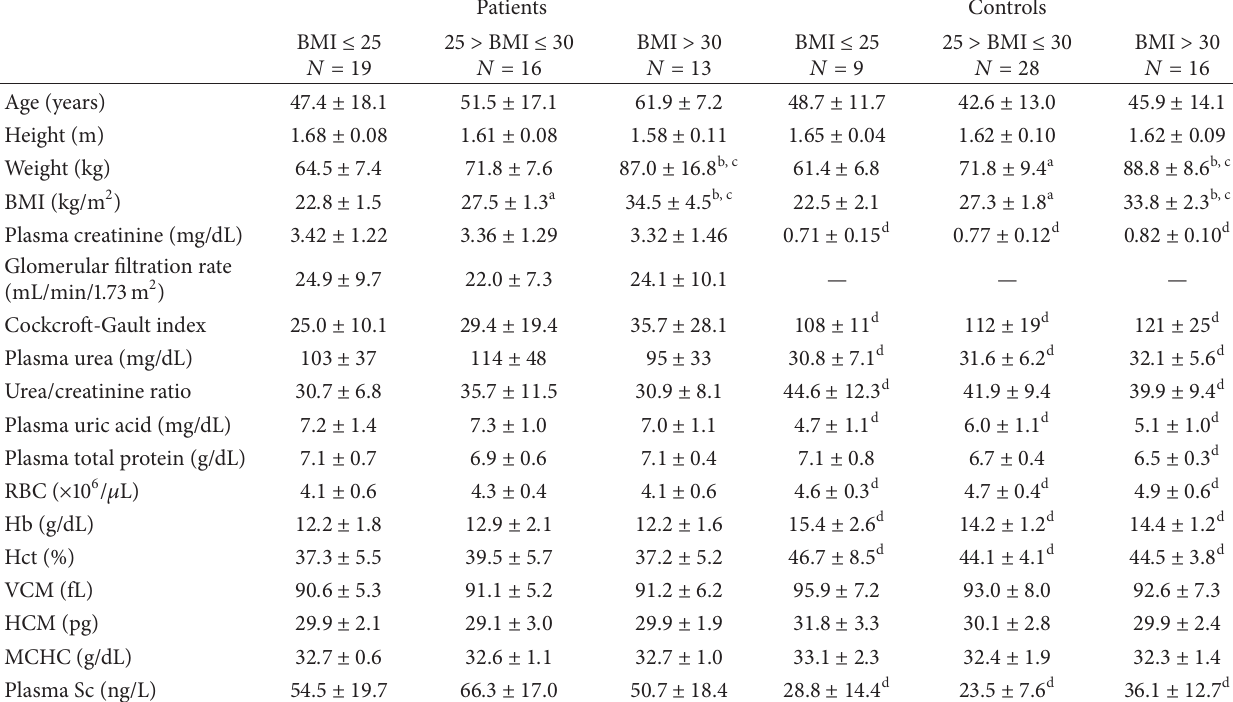
Table 3: Anthropometric, biochemical, and haemogram variables and plasma levels of Sc, by BMI.